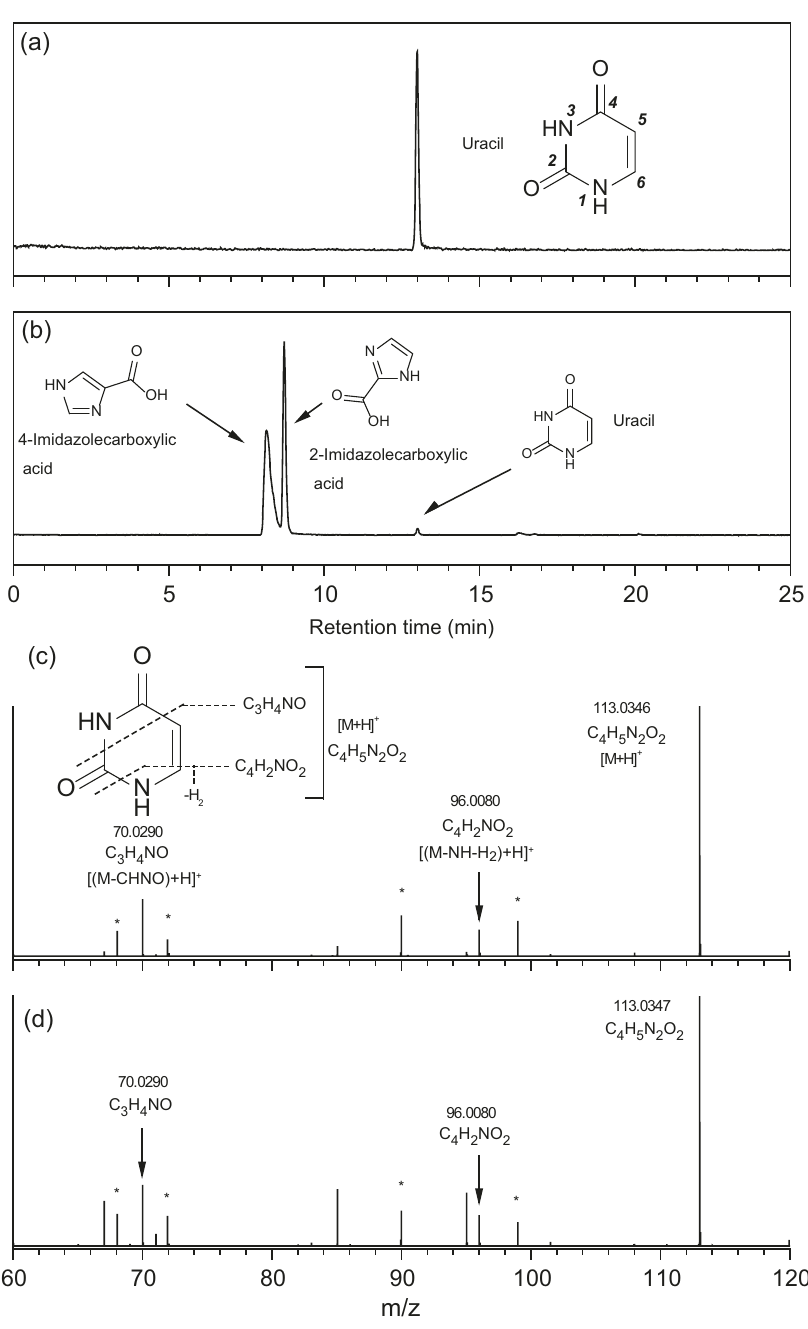
Fig. 2 Detection of pyrimidine nucleobases. Mass chromatograms at m/z = 113.0346 within a 3 ppm exact mass window at each monoisotopic mass for a the uracil (0.46 ng) standard reagent (STD) and b Murchison #1 extract measured using a Hypercarb column. In addition to uracil, 4-imidazolecarboxylic acid and 2-imidazolecarboxylic acid were detected as the dominant structural isomers in the Murchison #1 extract. Mass fragmentation patterns of c uracil STD and d uracil were detected in the Murchison #1 extract measured by MS/MS experiments. Mass peaks with a star (*) represent background signals in the fragmentation spectra present in both the meteorite and reference STD spectra. Bold italic numbers in panel a represent the numbering of atoms in the chemical structures of pyrimidine